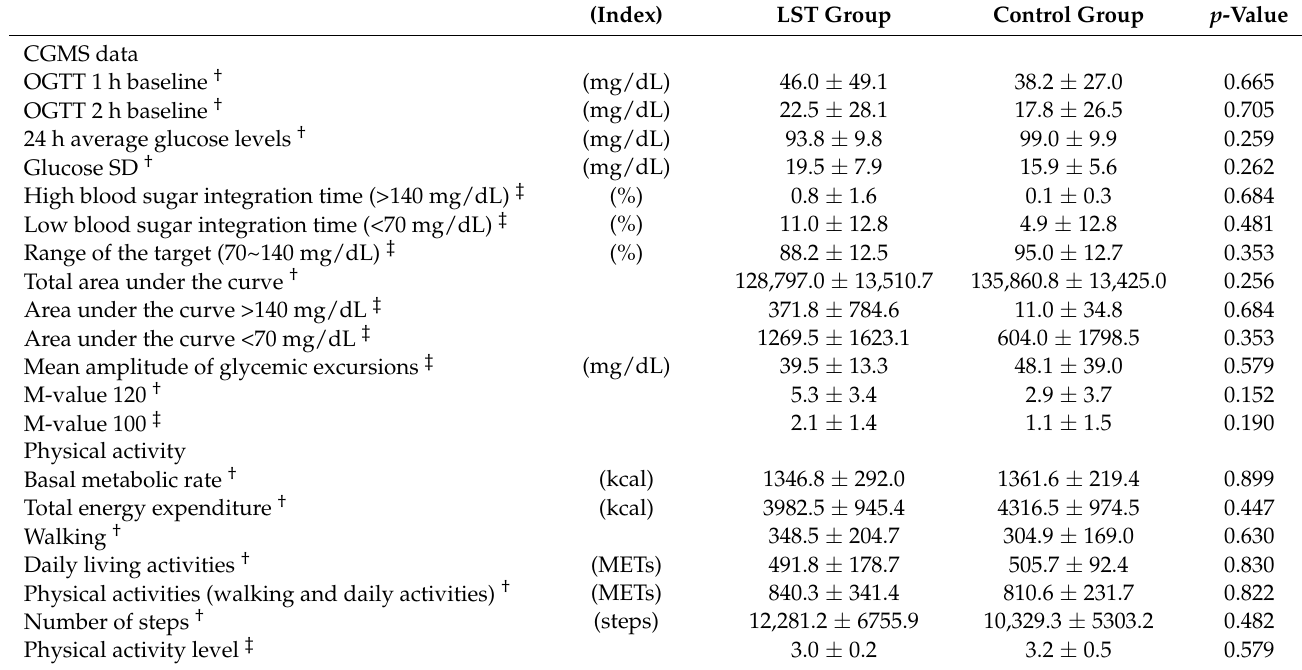
Table 3. A comparison between the LST and control